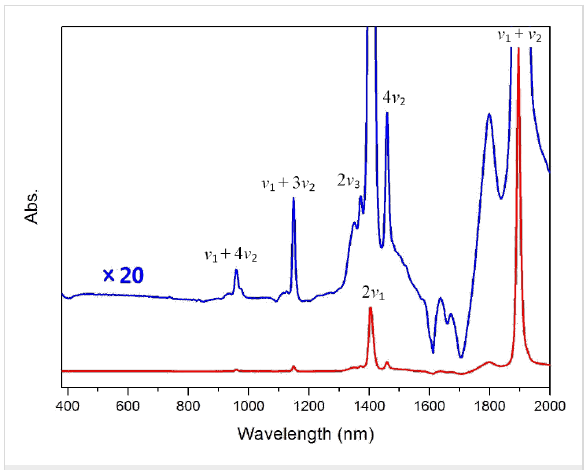
Figure 1: The UV–vis-NIR spectra of water in [BMIM] + [PF 6 ] − with dry [BMIM] + [PF 6 ] − used as a reference. The blue spectrum is a 20-times magnification of the red original spectrum in order to enlarge the weak signals.